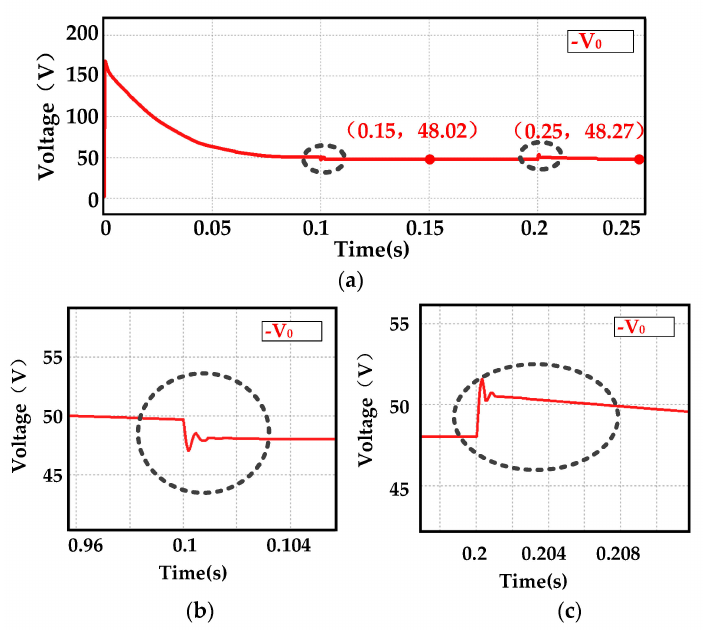
Figure 17. The waveform of output voltage. ( a ) is the overview waveform; ( b ) is the detail waveform when the resistor changes; ( c ) is the detail waveform when the input voltage